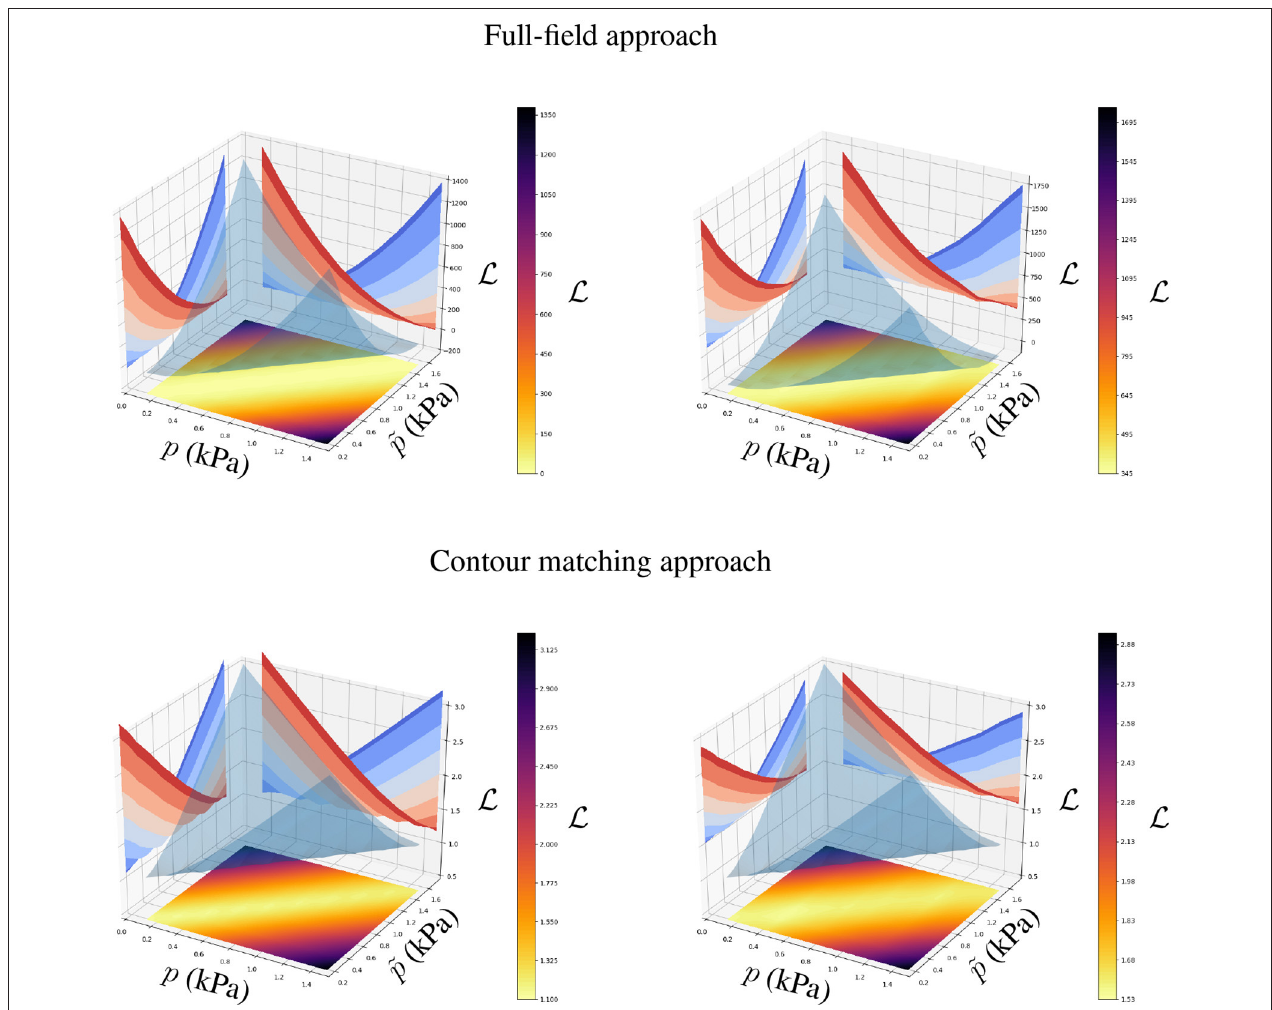
FIGURE 8 | Loss function for the full-field tracking and contour matching approaches with respect to p in the presence (right) and absence (left) of noise in the observations. The surface plot in the p - ˆ p plane and the opaque manifold represent the loss function value L ( p ) when ˆ p is the ground truth (optimal) value. Level curves in L - ˆ p and L - p planes correspond to parallel cuts of the opaque manifold for fixed values of p and ˆ p , respectively (blue to red shades indicate values of p and ˆ p that correspond to the ticks on their respective axes). Note that for a given ˆ p , L ( p ) is convex with the minimum p = ˆ p resulting in precise and well-behaved formulations for gradient-based